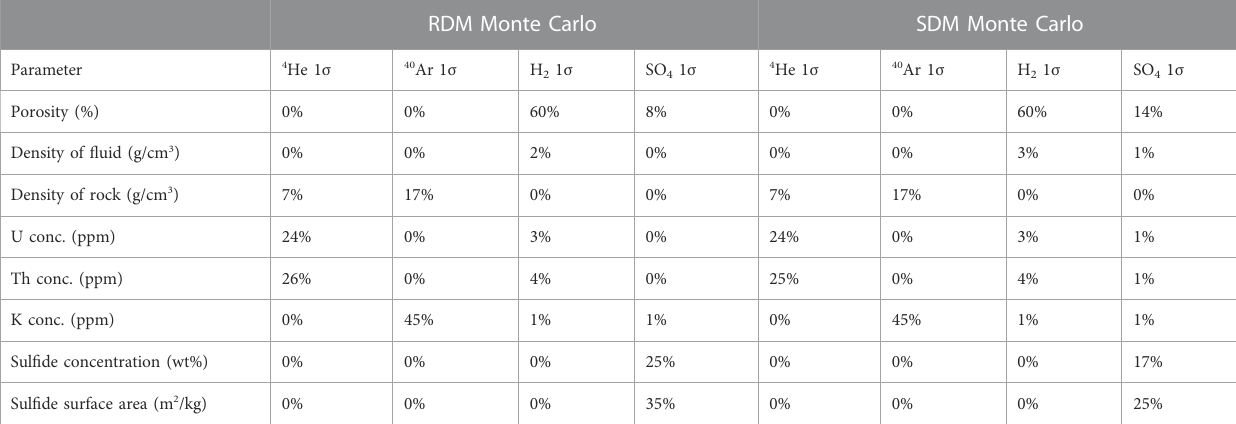
TABLE 5 The relative effect of each variable on the associated standard deviation associated with the production rates of each element. Here the relative importanceofeachinputrangeonthestandarddeviationwasevaluatedforbothmodels.Thevaluesgivenhererepresentthepercentagedecreaseintheoriginal standard deviations that result from changing the input parameter rangeto a fi xed,mid-point value.Due to the combinatorial effect inmultiparameterspacethe percentagesdonotaddupto100%.Forexample,replacingtheKconcentrationorrockdensitywithasinglevaluereducesthe1 σ associatedwith 40 Arby45%and 17% respectively. However, replacing them both at the same time results in a 98% reduction in the reported 40 Ar 1 σ